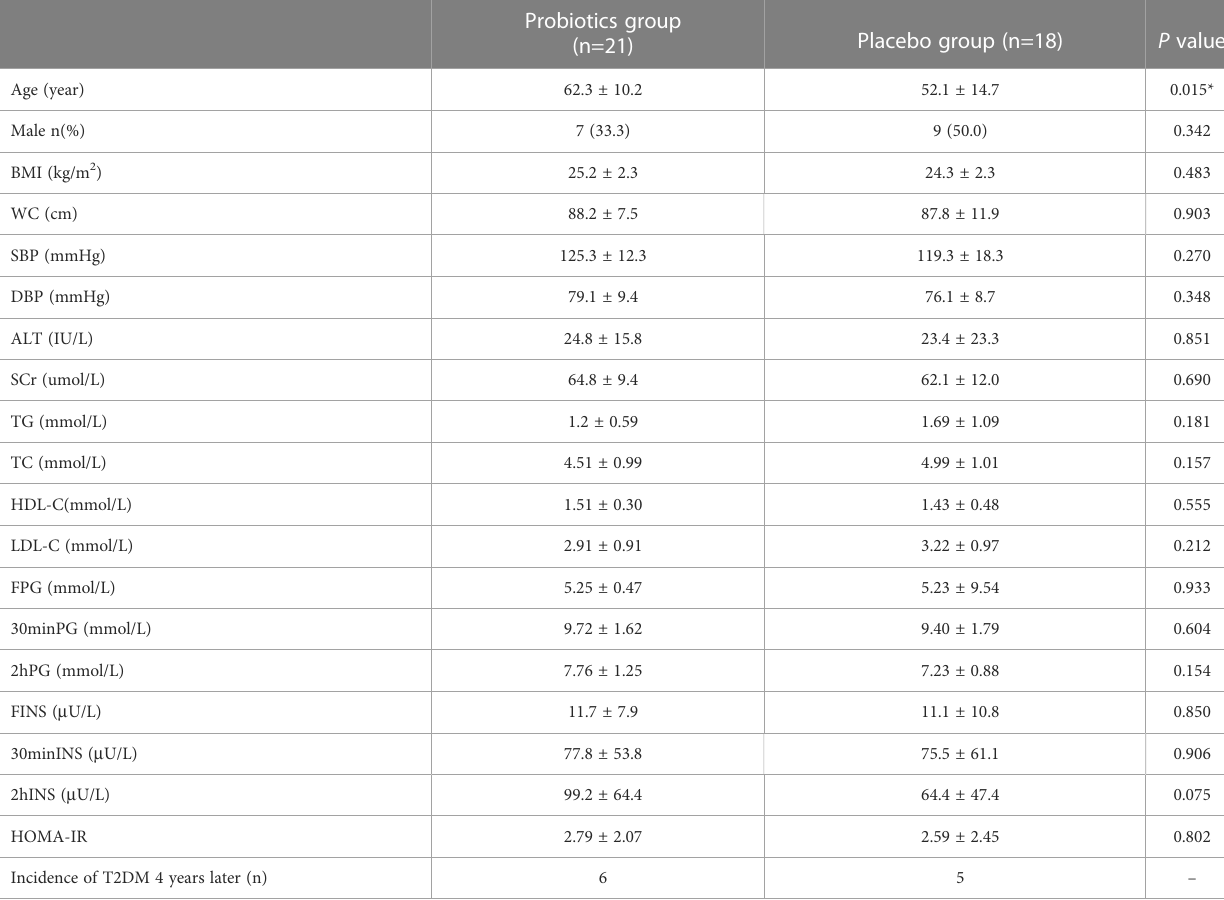
TABLE 1 Characteristics of undiagnosed T2DM patients at the end of 2-year follow up between the Probiotics and Placebo groups.